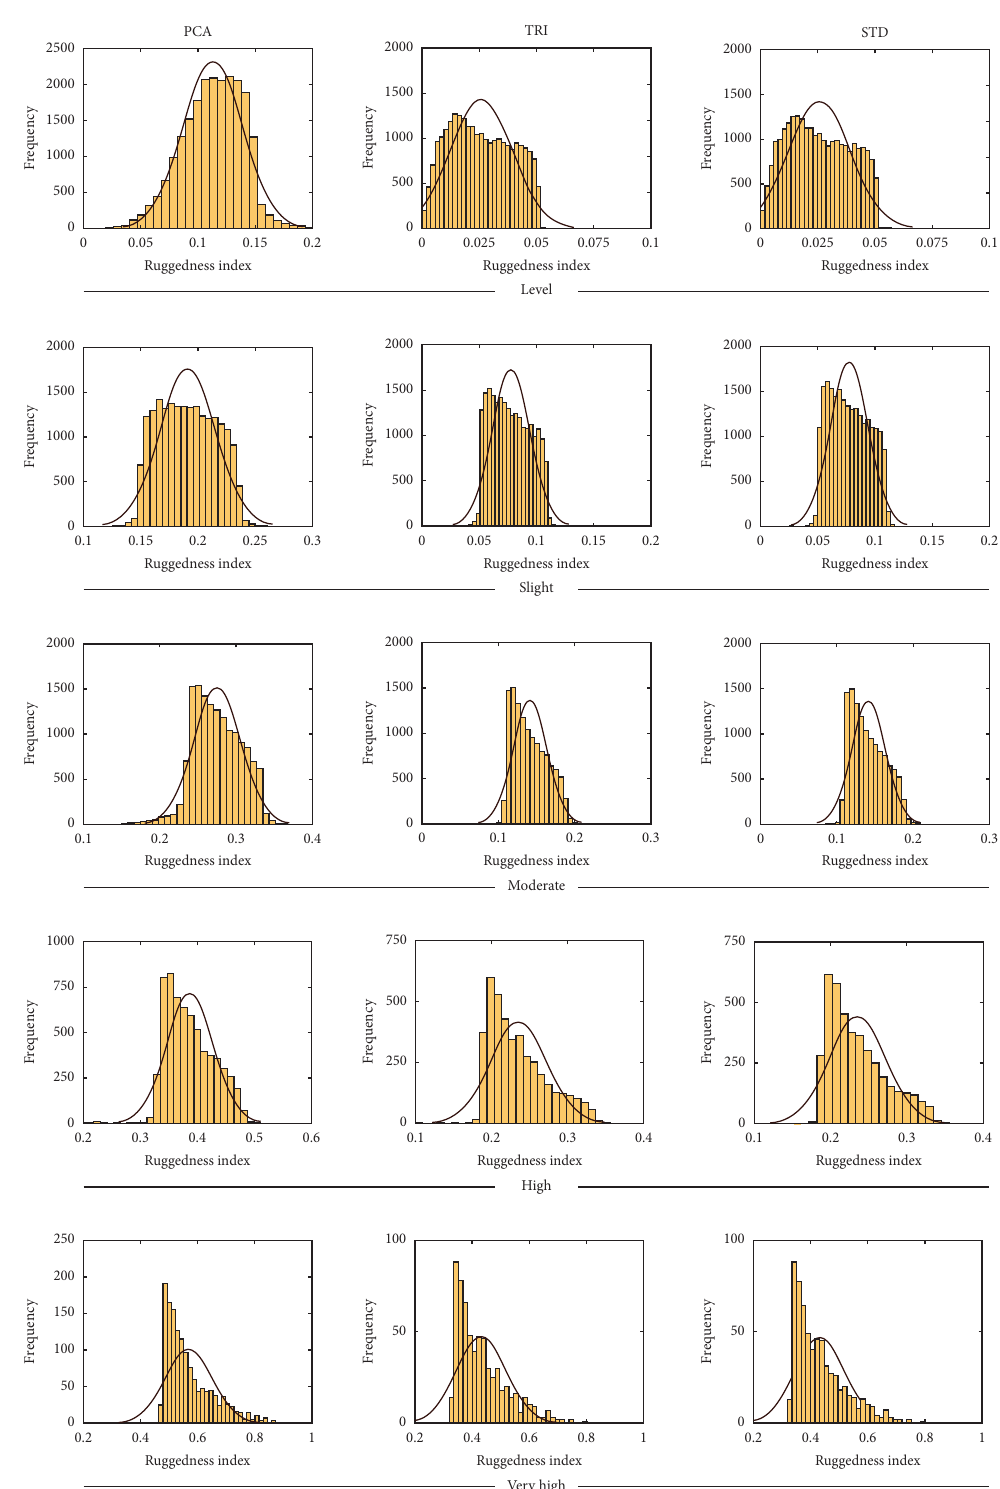
Figure 19: Distribution of dataset in each class of the investigated